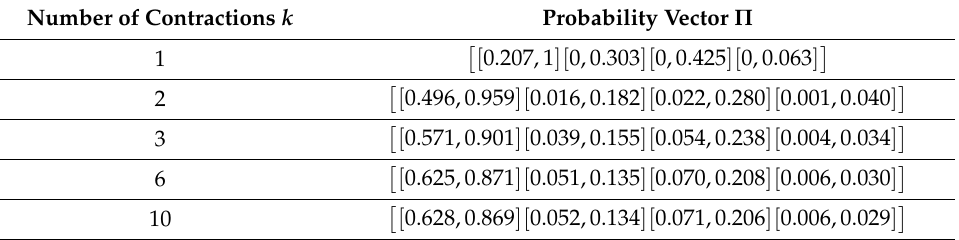
Table 4. The probability vector obtained after k contractions.